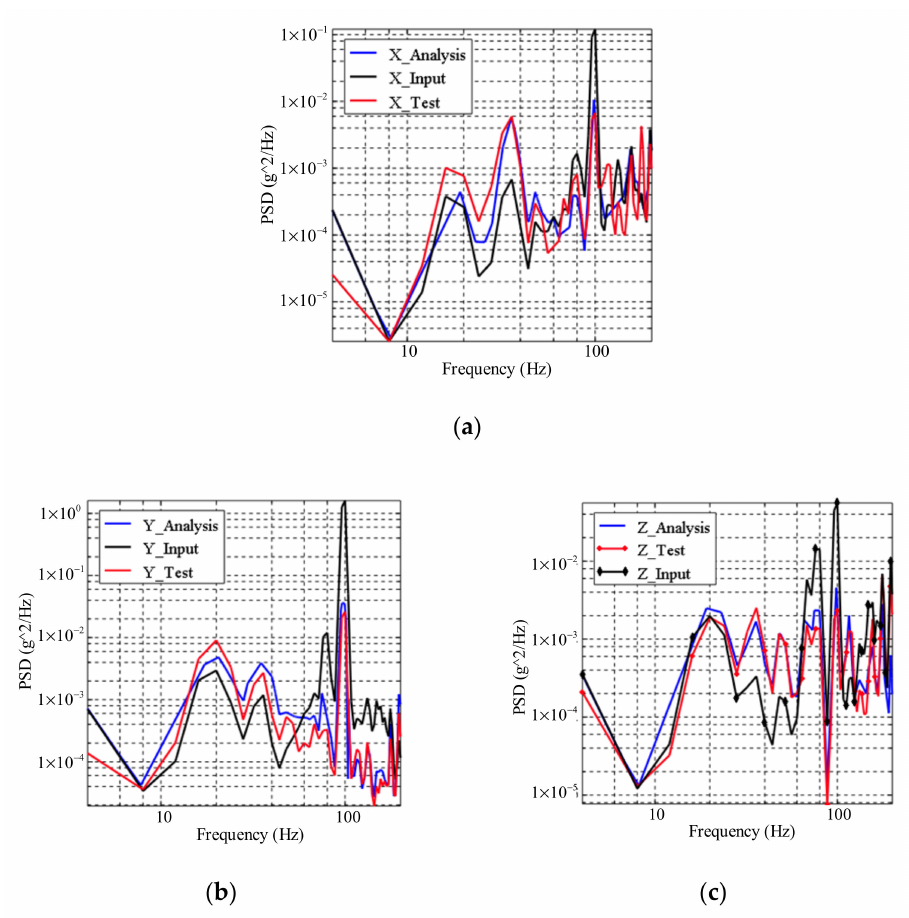
Figure 21. Comparison of simulation and test results: ( a ) X direction; ( b ) Y direction; ( c ) Z